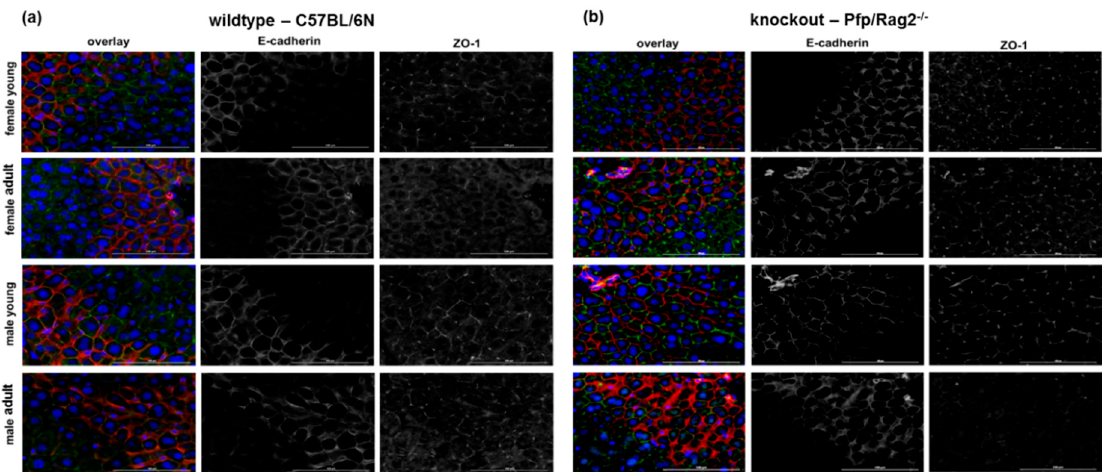
Figure 5. Expression of E-cadherin and ZO-1 in livers from wildtype ( a ) and knockout ( b ) female and male mice. The adherens junction protein E-cadherin (red) and the tight junction protein ZO-1 (green) were detected by immunofluorescence microscopy of liver sections. Pictures on the left side show the overlay, pictures in the middle the E-cadherin stain and right, the ZO-1 stain. Pictures are representative out of 3 different animals in each group.